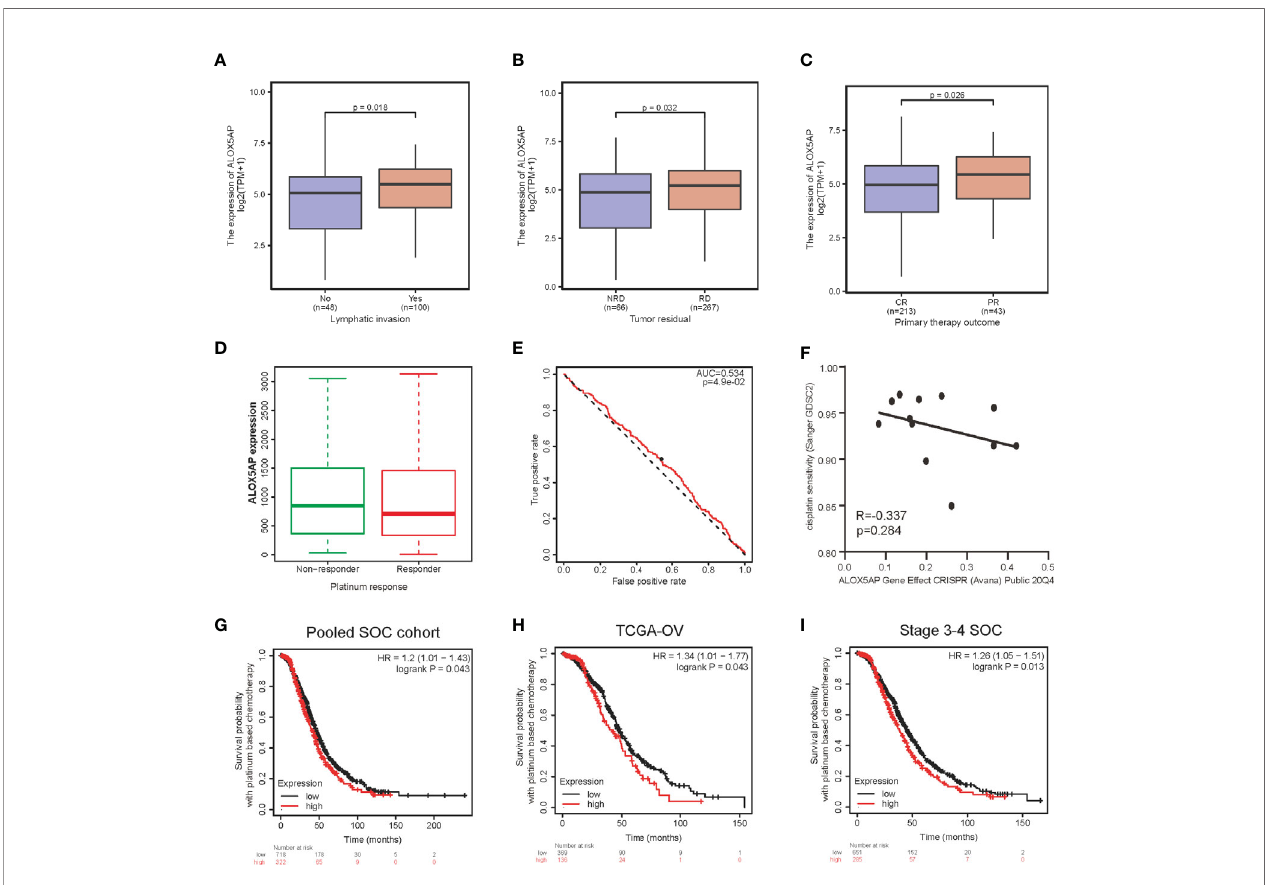
FIGURE 3 | Association between ALOX5AP expression and clinicopathologic characteristics. Comparison of ALOX5AP expression in different clinical conditions including: (A) lymphatic invasion, (B) tumor residual, (C) primary therapy outcome and (D) platinum response. (E) Receiver operating characteristic (ROC) curve was drawn to analyze the predictive value of ALOX5AP for platinum-containing chemotherapy responsiveness. (F) The gene effect of ALOX5AP on cisplatin responsiveness of ovarian adenocarcinoma cell lines. Kaplan Meier curves of SOC patients receipt of platinum-based chemotherapy with high or low ALOX5AP